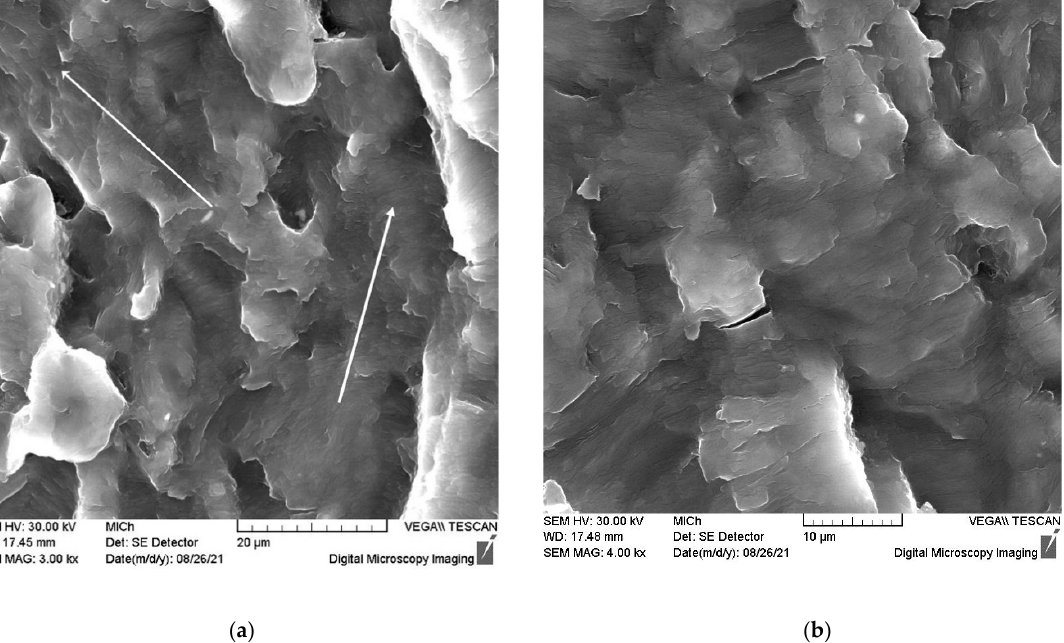
Figure 18. Scanning electron micrograph of the fracture surface taken from the transition region ( a ) at the same place with a higher magnification ( b ).